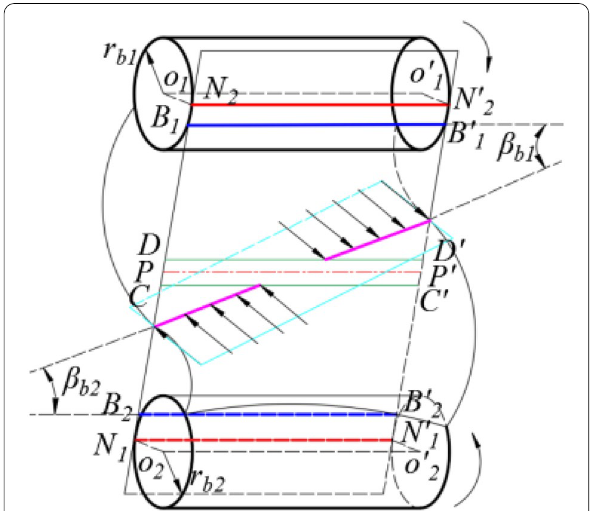
Figure 3 Contact area diagram of double involute gear pair